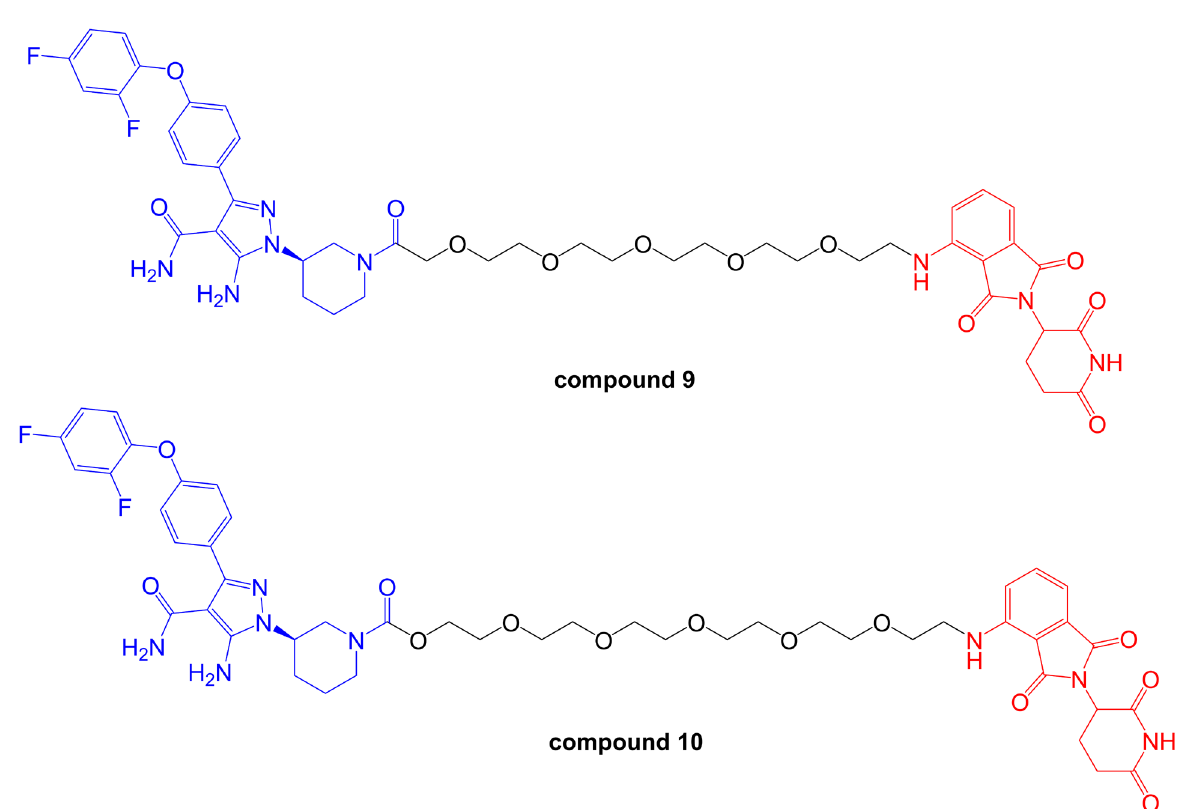
Figure 7. Structures of compounds 9 and 10. BTK-inhibiting warheads are colored blue and pomalidomide-derived CRBN-targeting moieties are colored red [93]. Note that compound 10 differs from compound 9 by having a longer